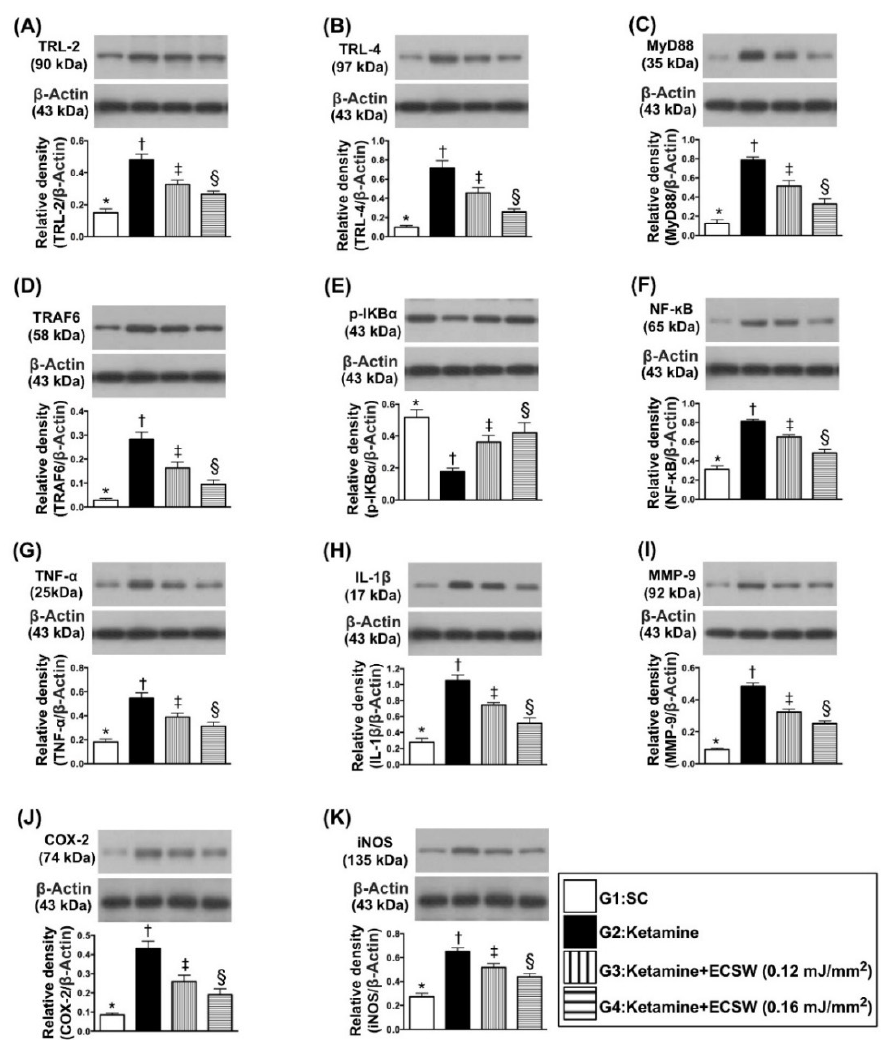
Figure 10. ECSW therapy suppressed the protein levels of inflammatory signalings in rat urinary bladder by day 42 after ketamine administration. ( A ) Protein expression of Toll-like receptor (TLR)-2, * vs. other groups with different symbols (†, ‡, §), p < 0.0001. ( B ) Protein expression of TLR-4, * vs. other groups with different symbols (†, ‡, §), p < 0.0001. ( C ) Protein expression of MyD88, * vs. other groups with different symbols (†, ‡, §), p < 0.0001. ( D ) Protein expression of TRAF6, * vs. other groups with different symbols (†, ‡, §), p < 0.0001. ( E ) Protein expression of p-IKB- α , * vs. other groups with different symbols (†, ‡, §), p < 0.0001. ( F ) Protein expression of NF- κ B, * vs. other groups with different symbols (†, ‡, §), p < 0.0001. ( G ) Protein expression of TNF- α , * vs. other groups with different symbols (†, ‡, §), p < 0.0001. ( H ) Protein expression of interleukin (IL)-1ß, * vs. other groups with different symbols (†, ‡, §), p < 0.0001. ( I ) Protein expression of MMP-9, * vs. other groups with different symbols (†, ‡, §), p < 0.0001. ( J ) Protein expression of COX-2, * vs. other groups with different symbols (†, ‡, §), p < 0.0001. ( K ) Protein expression of and iNOS, * vs. other groups with different symbols (†, ‡, §), p < 0.0001. All statistical analyses were performed by one-way ANOVA, followed by Bonferroni multiple comparison post hoc test ( n = 6 for each group). Symbols (*, †, ‡, §) indicate significance (at 0.05 level). ECSW = extracorporeal shock wave.